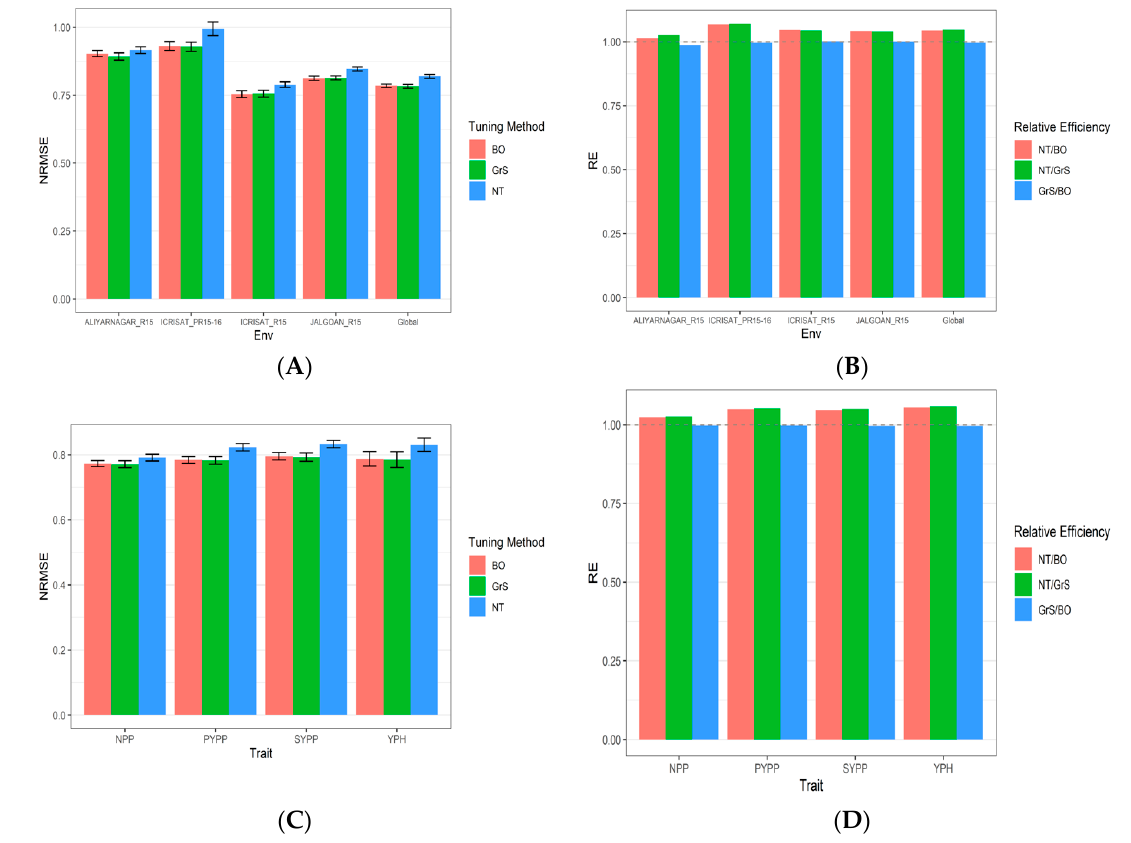
Figure 3. ( A ) The prediction performance for dataset 3, Groundnut dataset in terms of normalized root mean squared error (NRMSE) for each environment across traits (ALIYARNAGAR_R15, ICRISAT_PR15-16 ICRISAT_R15 and JALGOAN_R15), across environments and traits (Global) with three tuning strategies (BO, GrS and NT) under 7 Fold Cross-Validation (7FCV). ( B ) The relative efficiency for each environment across traits (ALIYARNAGAR_R15, ICRISAT_PR15-16 ICRISAT_R15 and JALGOAN_R15), across environments and traits (Global) with three tuning strategies (BO, GrS and NT) under 7 Fold Cross-Validation (7FCV). ( C ) The prediction performance in terms of normalized root mean squared error (NRMSE) for each trait (NPP, PYPP, SYPP, YPH)) across environments with three tuning strategies (BO, GrS and NT) under 7FCV. ( D ) The relative efficiency for each trait (NPP, PYPP, SYPP, YPH) across environments with three tuning strategies (BO, GrS and NT) under 7 Fold Cross-Validation (7FCV). When RE > 1, the denominator method outperforms the numerator in terms of prediction performance.